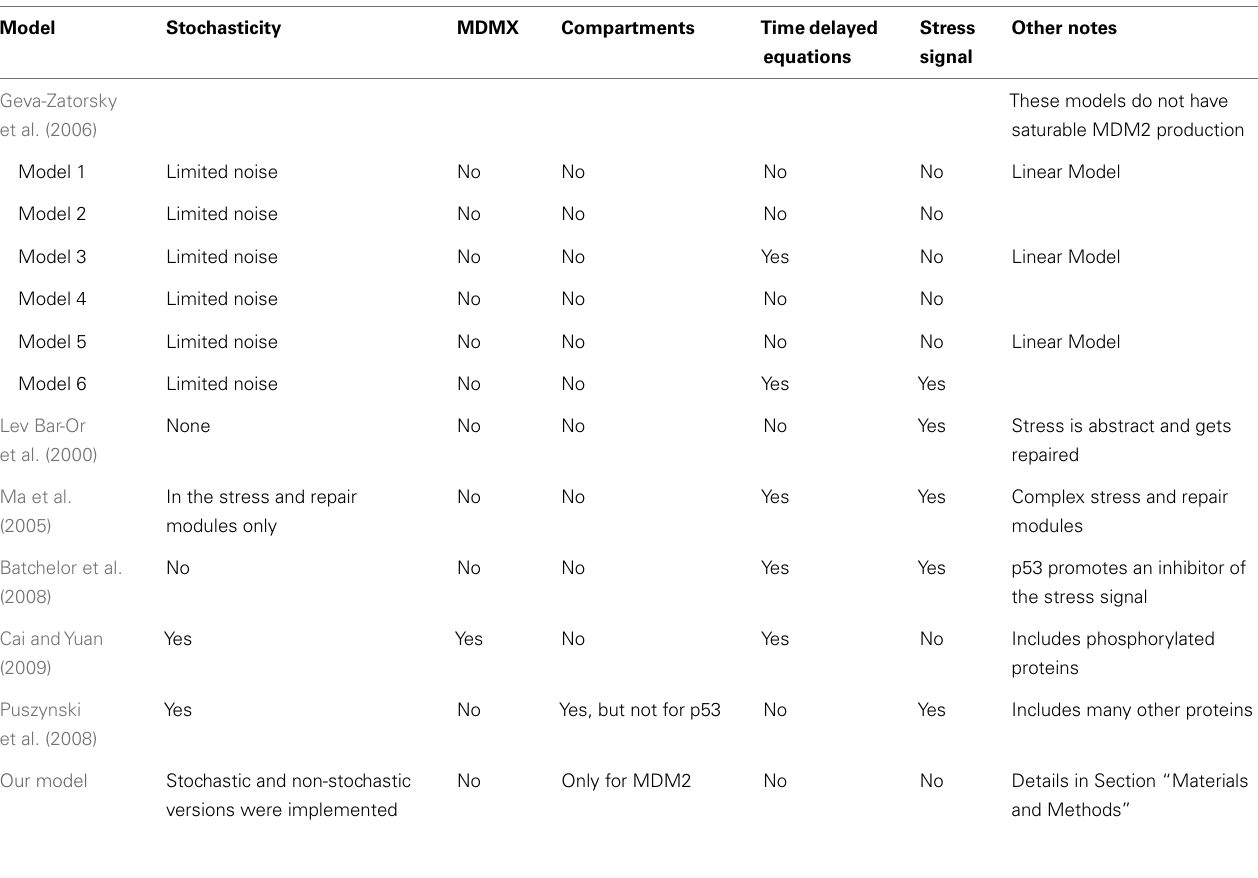
Table 1 | Key features of various models of p53